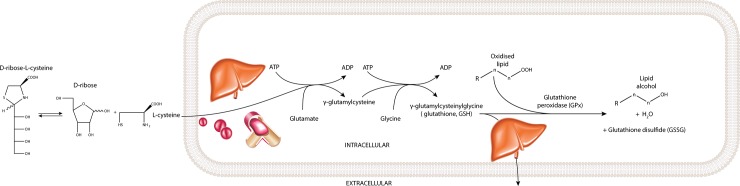
Proposed mode of action of ribose-cysteine.Ribose-cysteine releases L-cysteine via hydrolysis in the plasma compartment which is taken up by the liver and utilised to promote GSH synthesis. The increase in GSH promotes an increase in GPx activity to give a reduction in oxidised lipid content. Excess GSH is exported by the liver.